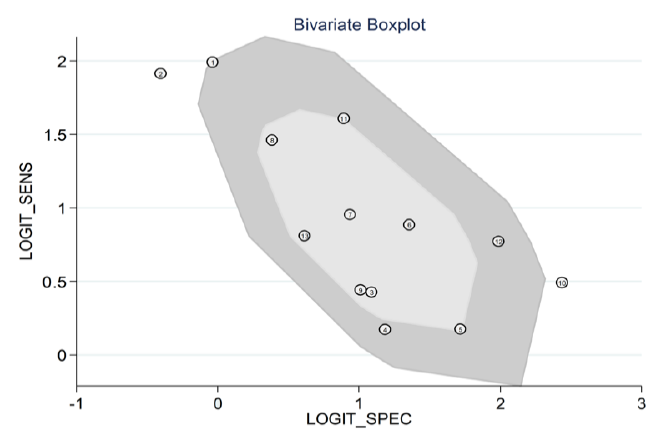
Figure 19. Bivariate boxplot exploring heterogeneity across studies.